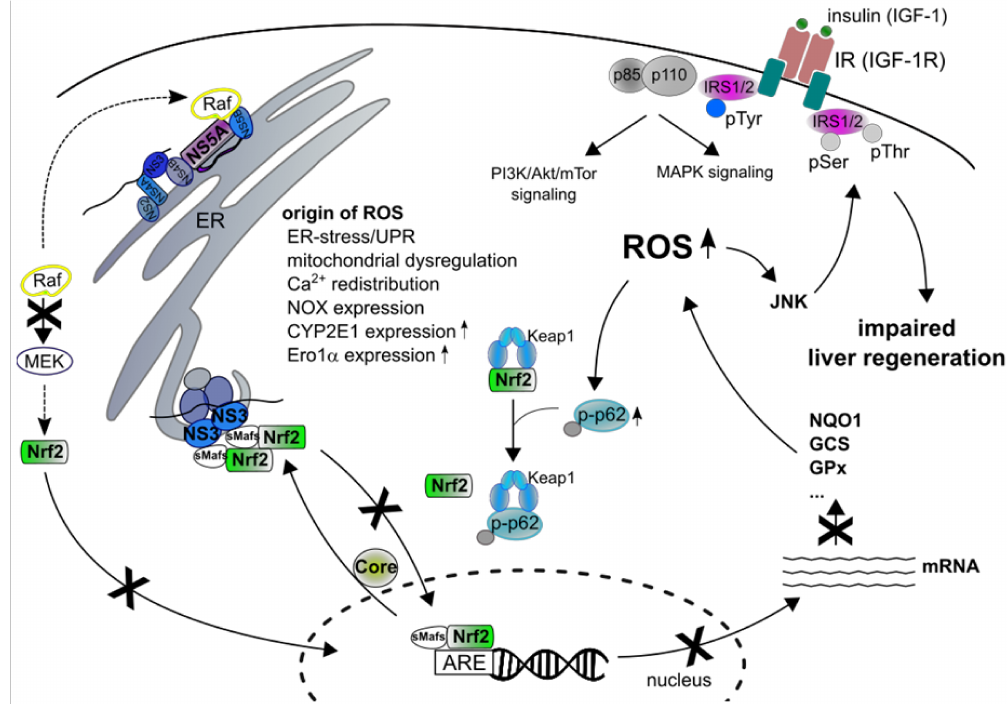
Figure 1. Interference of hepatitis C virus (HCV) with the nuclear factor erythroid 2 (NF-E2)-related factor 2 (Nrf2) / Keap1-signaling pathway. Lines labelled with an “X” represent blocked processes, dotted lines describe indirect processes, solid lines describe translocations or direct e ff ects.HCV is associated with oxidative stress in liver cells that results in increased levels of ROS. ROS in HCV infected hepatocytes can be related to ER-stress and the UPR, mitochondrial dysregulation, Ca 2 + redistribution, activation of NADPH oxidases and enhanced expression of CYP2E1 and Ero1 α . The increased ROS-levels further trigger phosphorylation of p62 on Ser349 that activates Nrf2. Based on the impaired Nrf2 / Keap1-signaling pathway in HCV-infected cells, the oxidative stress cannot be compensated.